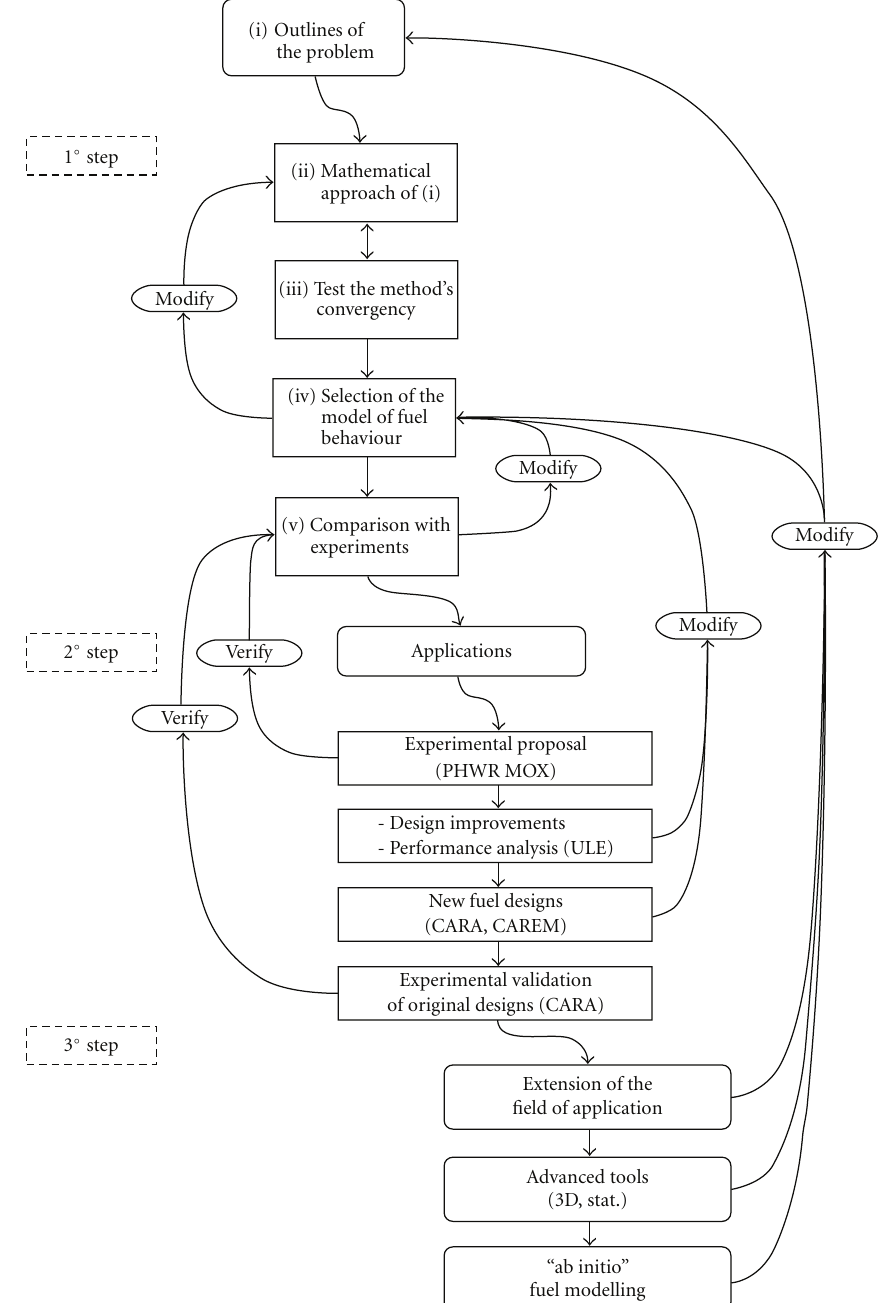
Figure 1: Roadmap of the development of the BaCo